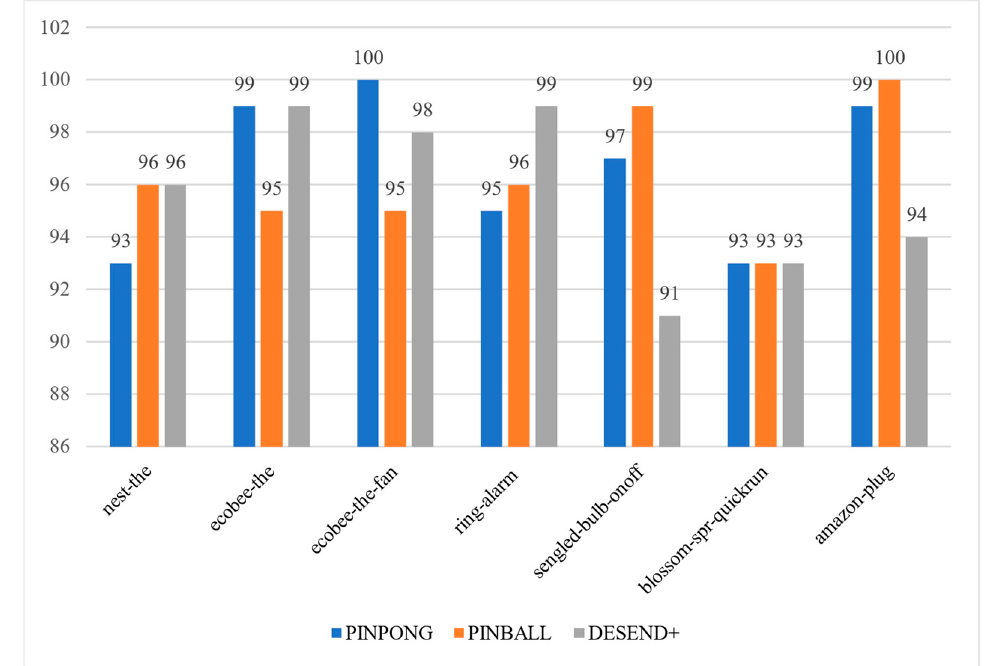
Figure 10. Event detection experiment.